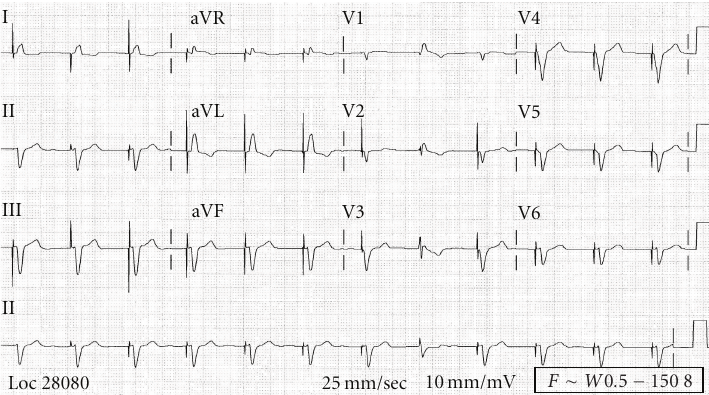
Figure 2: Baseline ECG (two months prior to presentation): ventricular-paced rhythm at the rate of 70, corrected QT interval (QTc) of 410milliseconds